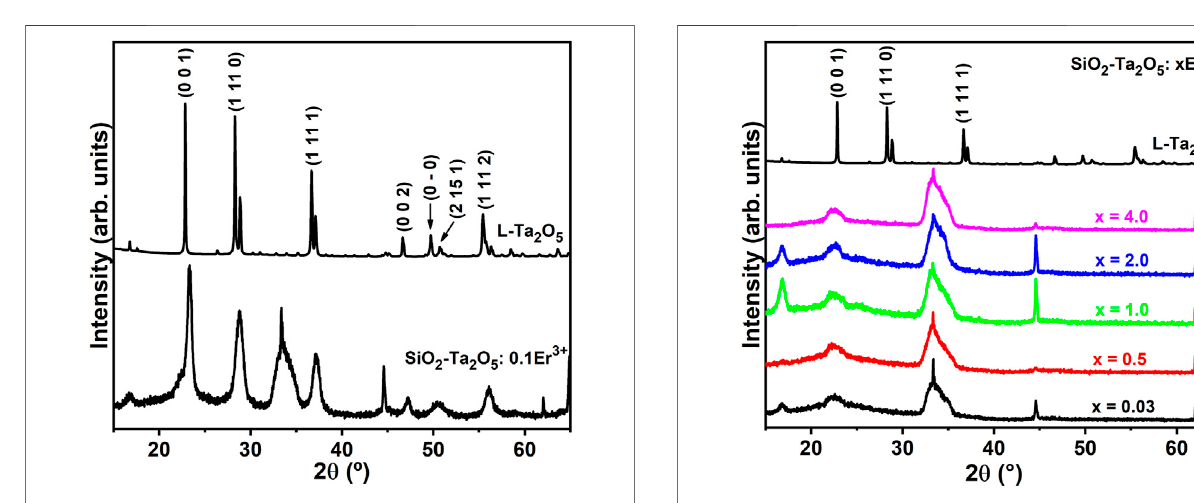
FIGURE4| Powder XRDpatterns ofthe0.03, 0.5,1.0, 2.0, and4.0 mol % Er 3+ -doped SiO 2 -Ta 2 O 5 fi lms.